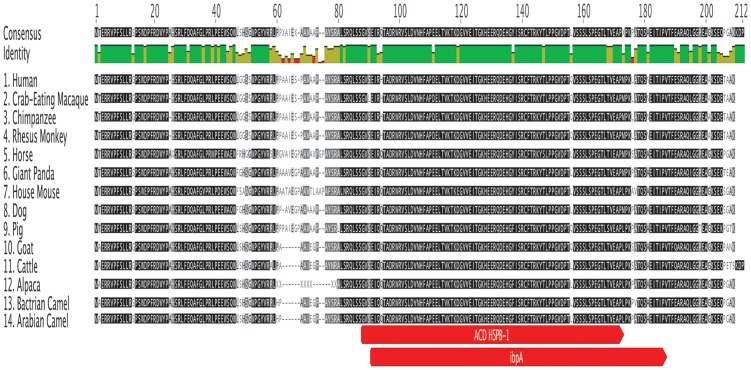
Multiple alignment of amino acid sequence of Arabian camel HSPB-1 protein with that in other 13 mammalian species.Identical amino acids are marked in green color, and typical ACD and ipbA domains are showed in red.